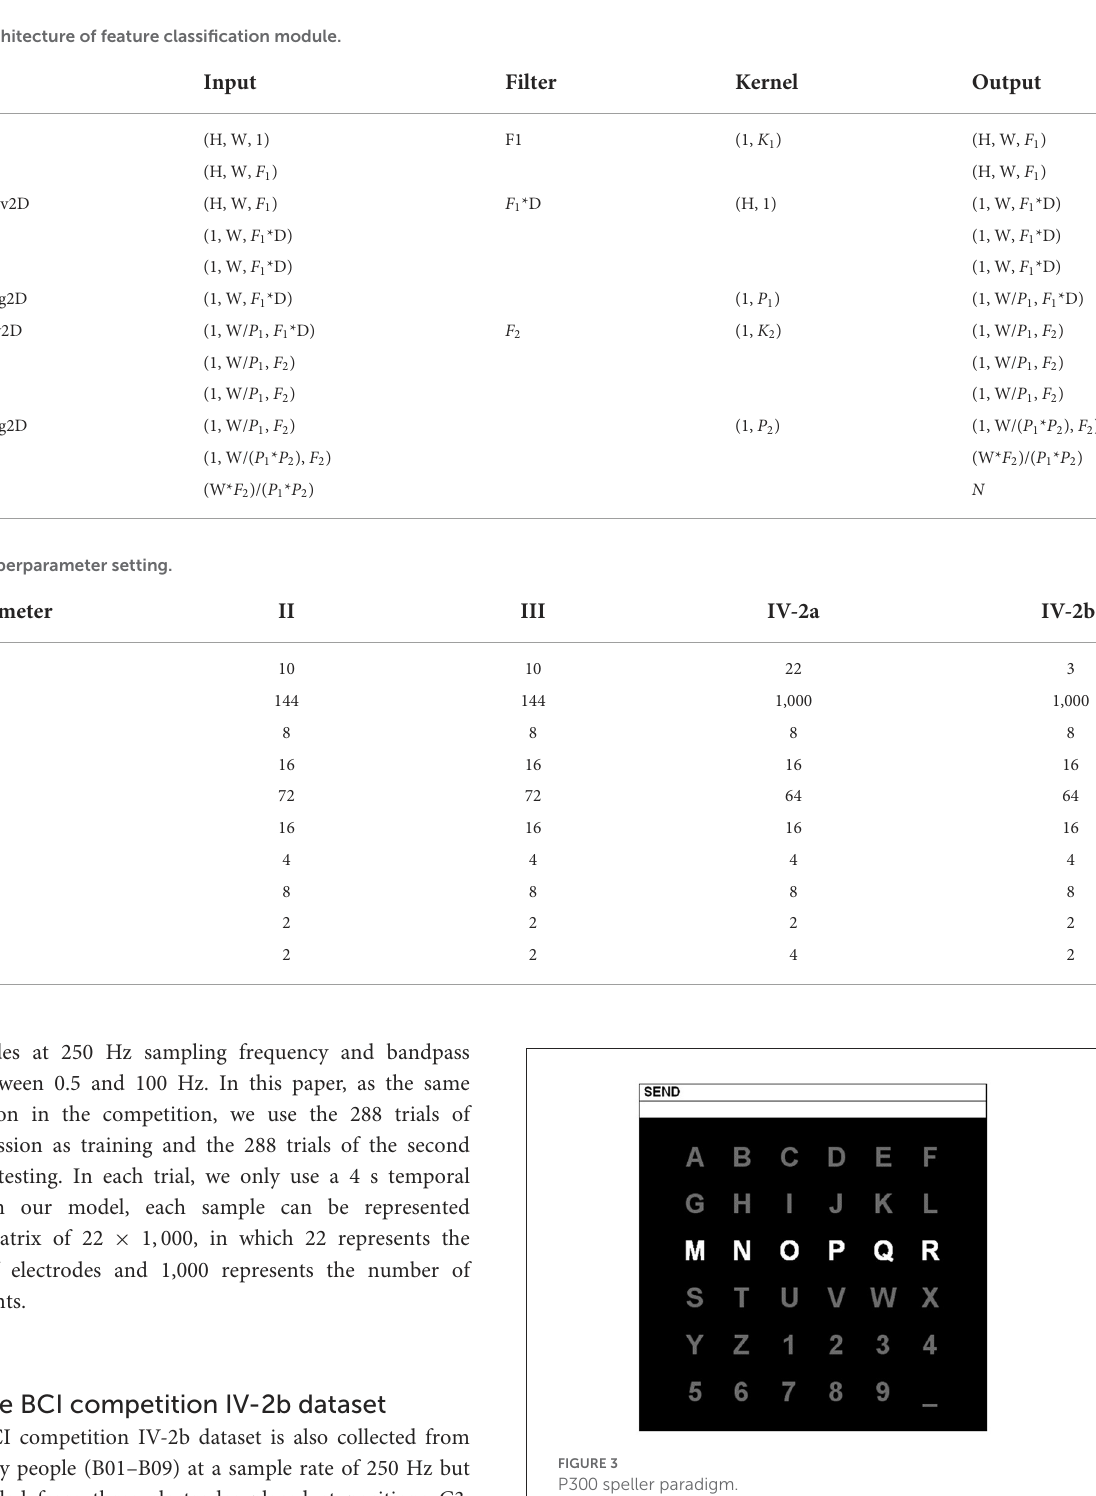
TABLE 1 Architecture of feature classification module.